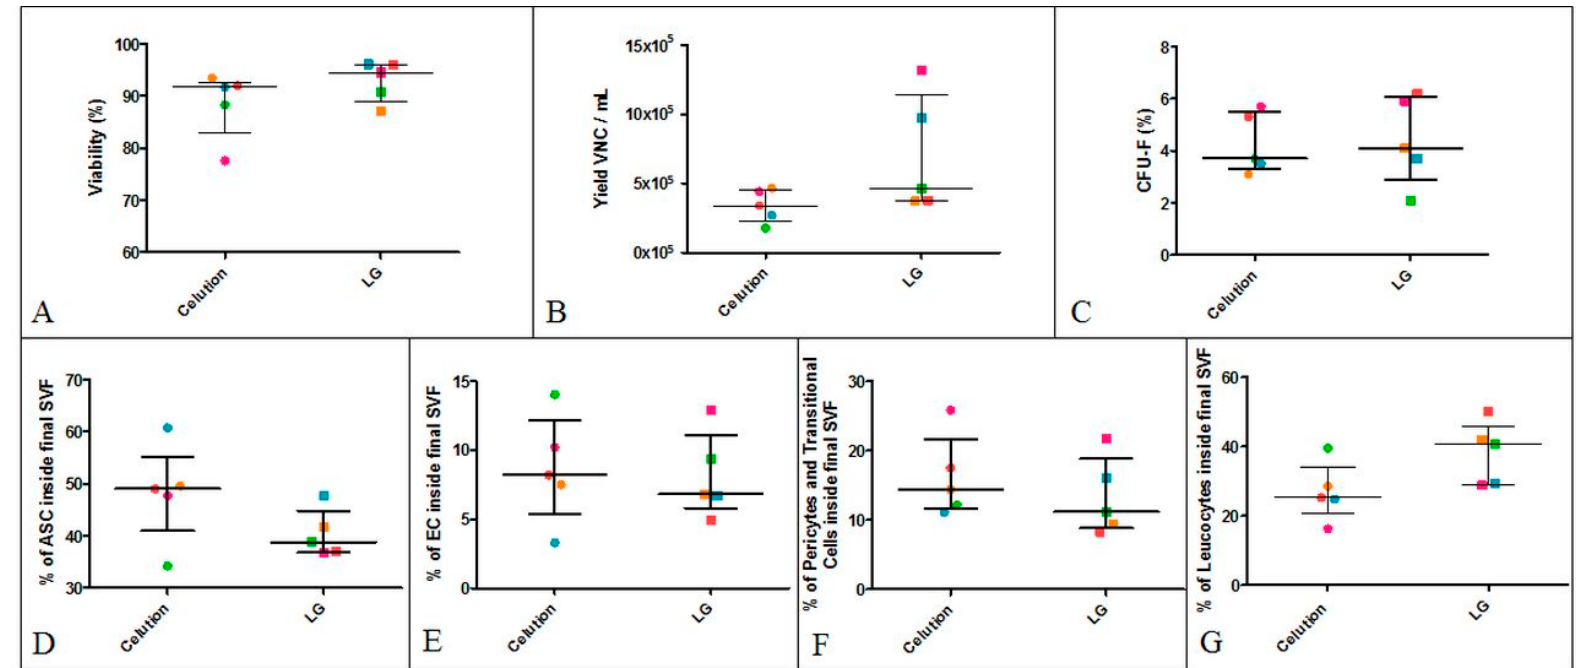
Figure 5. Intra-donor comparative analysis of SVF produced using the Celution device or final LG protocol. Five SVF preparations were produced from five donors with the Celution device or LG protocol. Each color represents a donor. ( A ) Viability ( p -value = 0.3090), ( B ) yield of VNCs per mL AT ( p -value = 0.1256), ( C ) CFU-F ( p -value = 0.7790), ( D ) % of ASCs ( p -value = 0.0722), ( E ) % of ECs ( p -value = 0.7610), ( F ) % of pericytes and transitional cells ( p -value = 0.2874), and ( G ) % of leukocytes ( p -value = 0.0517) were evaluated.